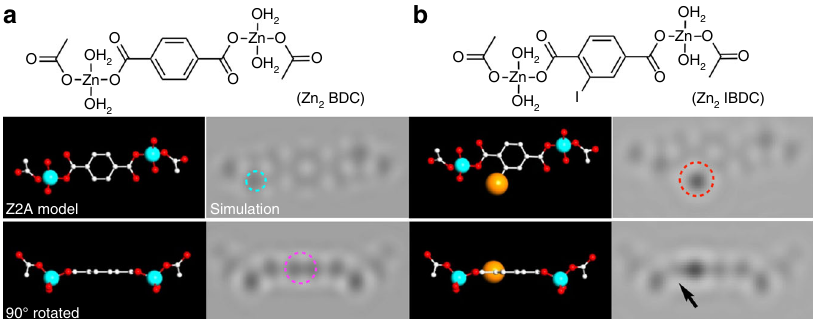
Fig. 4 Molecular models and TEM simulation images of Zn-BDC complexes. a dinuclear Zn-BDC. b dinuclear Zn-IBDC. Positions of zinc atoms (light blue), benzene rings parallel to the electron beam (purple), and iodine atoms (red) are circled in a and b